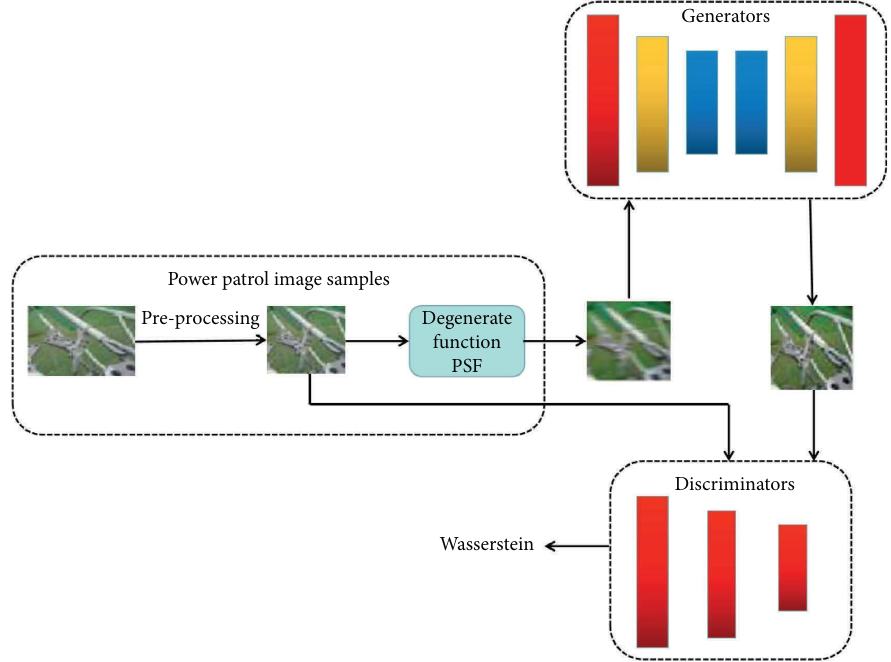
Figure 9: Overall process of deblurring power inspection